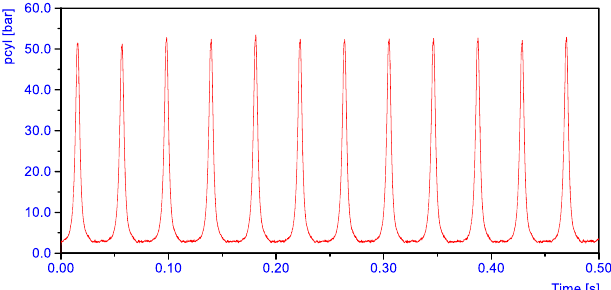
Fig. 5. Fragment of the pressure in the first cylinder – operating point No. 1